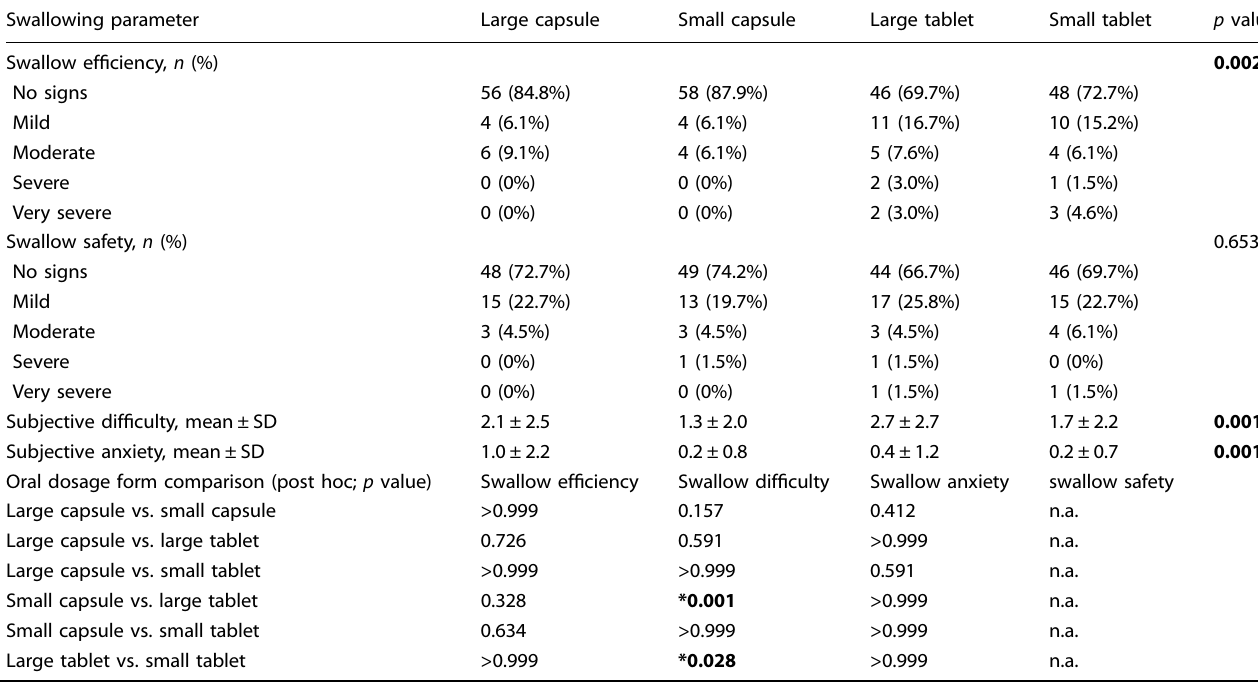
Table 2. Number and percentage of cases with impaired swallowing ef fi ciency, swallowing safety, mean subjective dif fi culty, mean subjective anxiety as well as p value of the Friedman ’ s-test depending on the oral dosage form and the Bonferroni adjusted p values in the post hoc analysis comparing the different oral dosage forms.